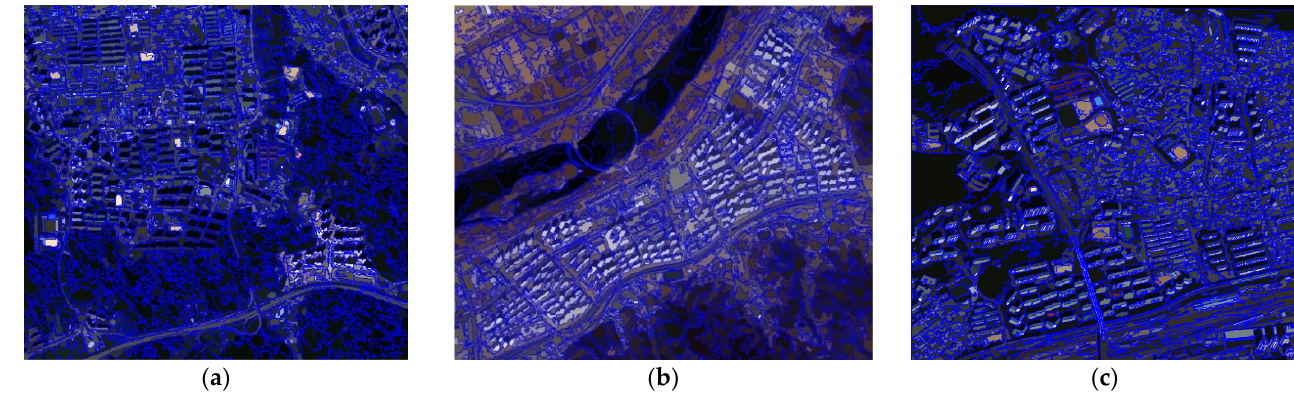
Figure 6. Multiresolution segmentation images: ( a ) Site 1; ( b ) Site 2; and ( c ) Site 3 imagery. Table 3. Multiresolution segmentation parameter values by site.